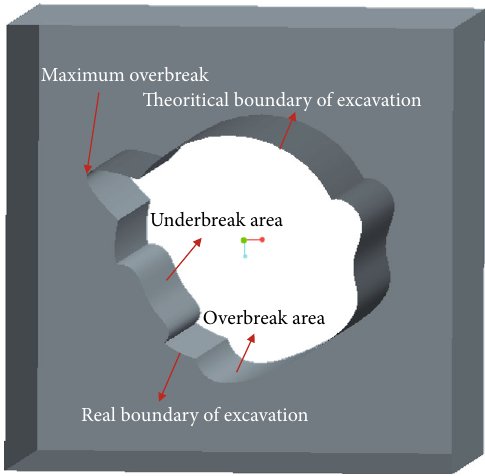
Figure 1: Overbreak and underbreak in the tunnel smooth blasting.